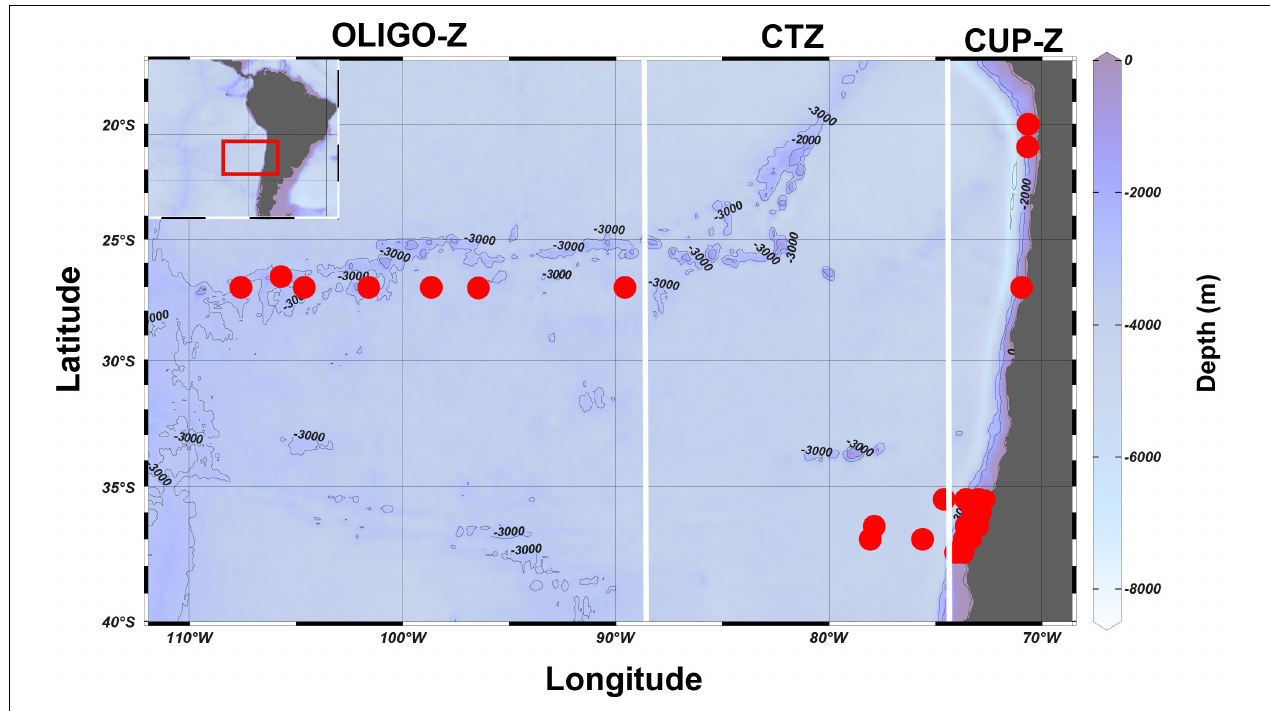
FIGURE 1 | The southeast Pacific region where the samplings were made between the years 2002–2015. The sampling stations are indicated by a red circle. The study area was divided in three zones according to surface chlorophyll-a values: coastal upwelling zone (CUP-Z), mesotrophic coastal transition zone (CTZ), and oligotrophic zone (OLIGO-Z) (González et al., 2019). The bathymetry of each zone is indicated by its color and